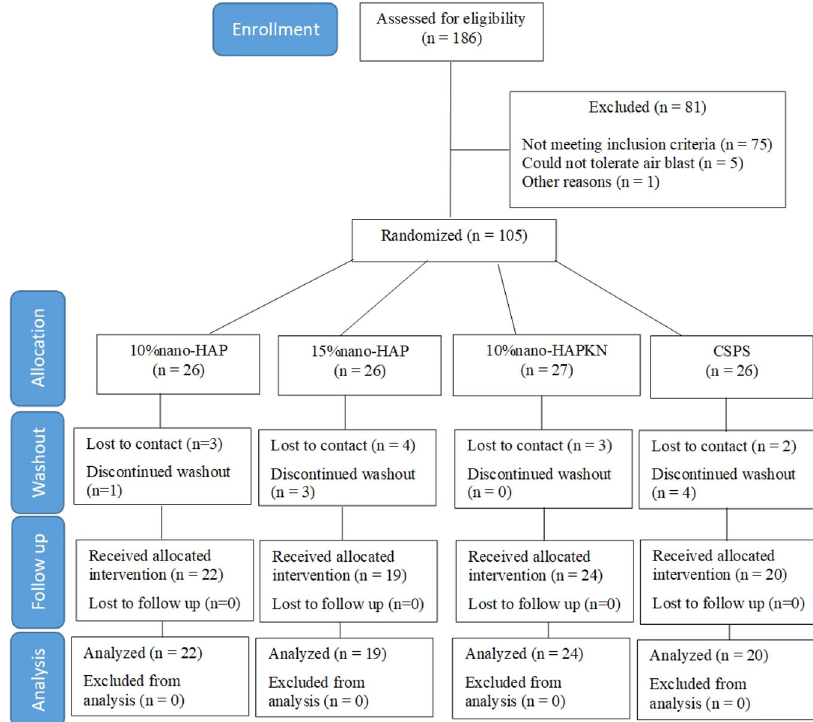
Fig. 1 Patient fl ow diagram. CSPS calcium sodium